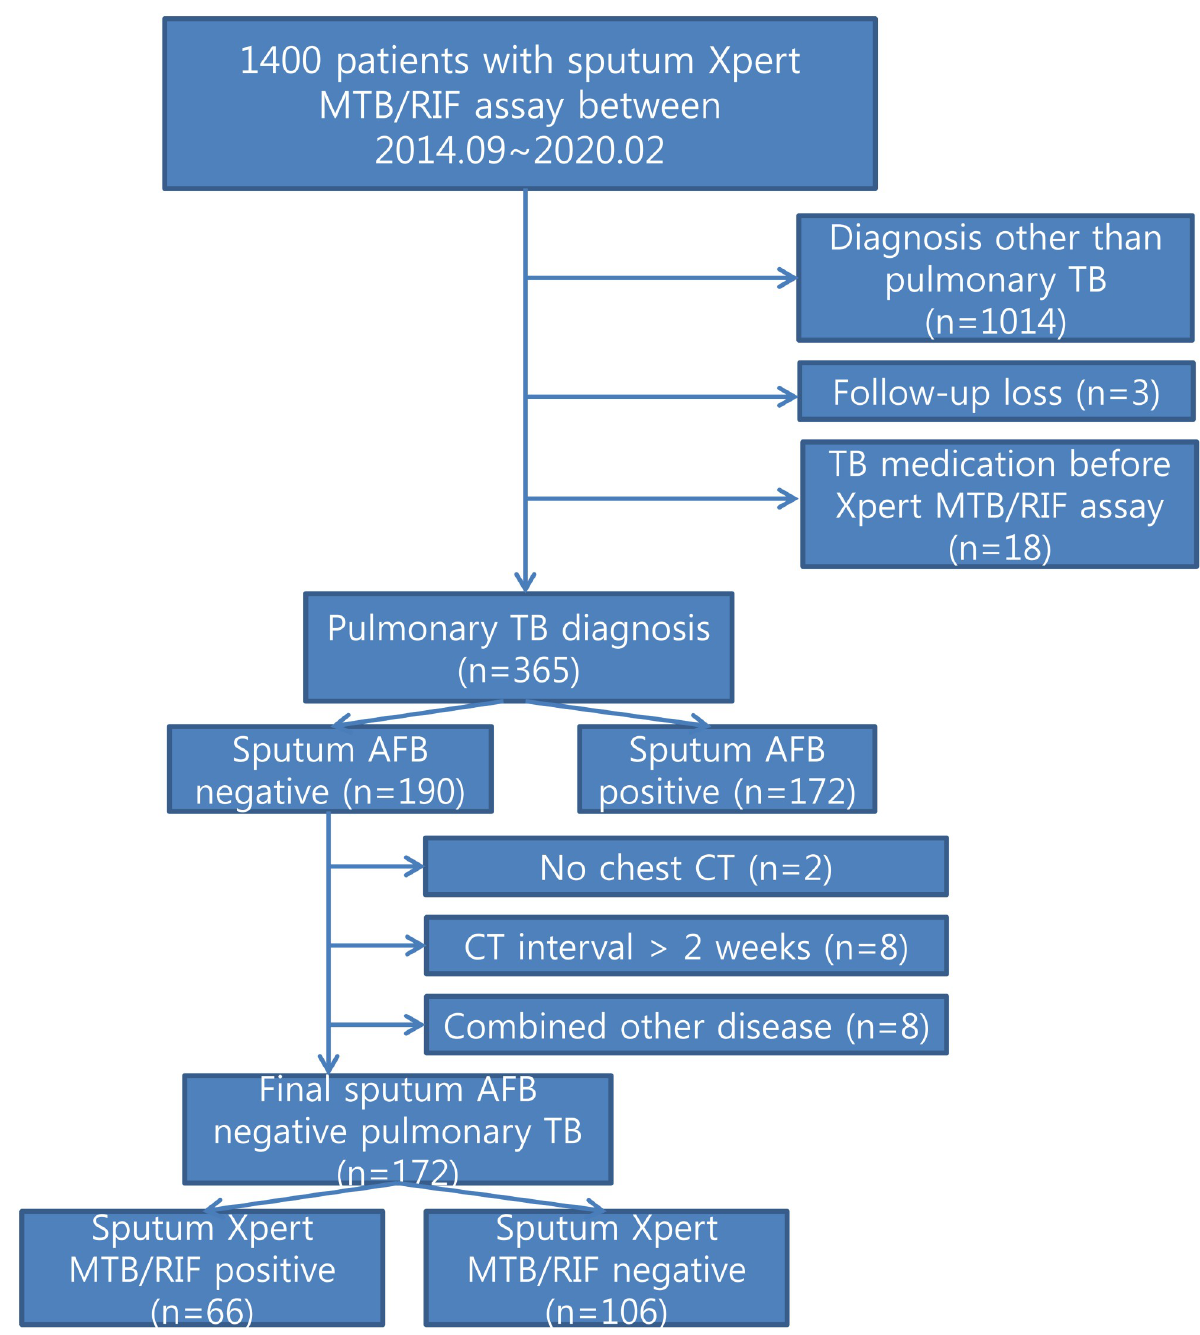
Fig 1. Patient selection for comparison of smear-negative pulmonary TB between Xpert MTB/RIF positive and negative. positive results for BAL culture (53.3 vs. 84.6%, p = 0.042) and for BAL Xpert MTB/RIF (55.6% vs. 84.6.%, p = 0.053), but the latter was not statistically significant. TB medication start periods in patients with Xpert MTB/RIF negative were longer than that in patients with Xpert MTB/RIF positive (11.3 days vs. 5.0 days, p = 0.001).